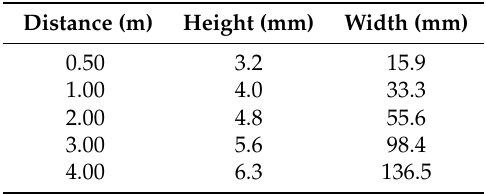
Table 3. Beam size at multiple distances w/o